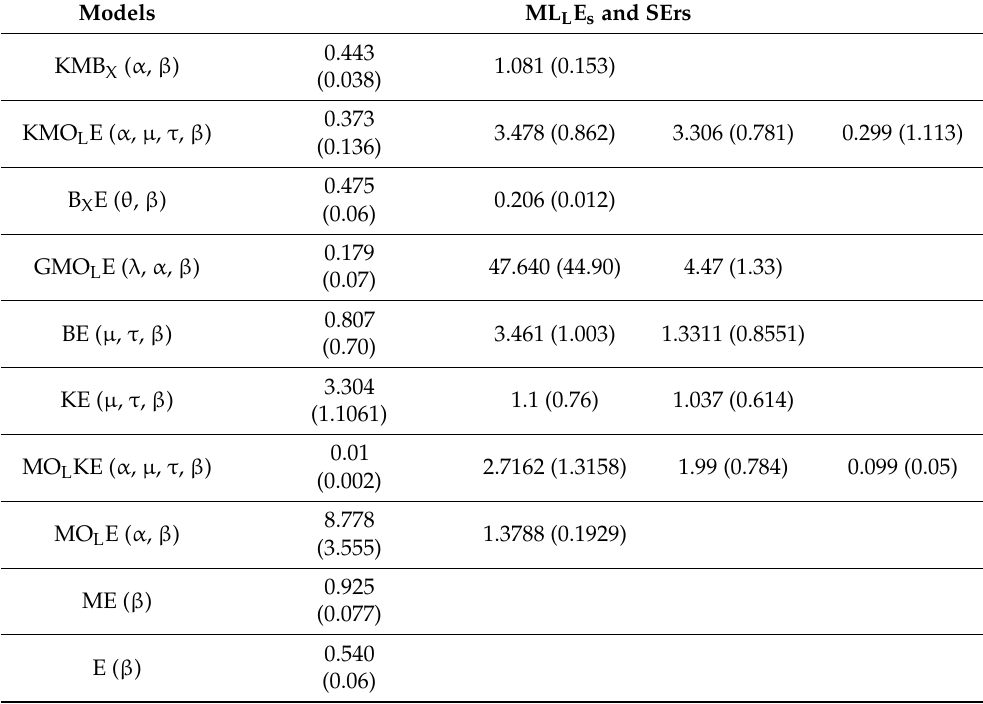
Table 7. Numerical values of ML L E s and (SErs) for the first data set.